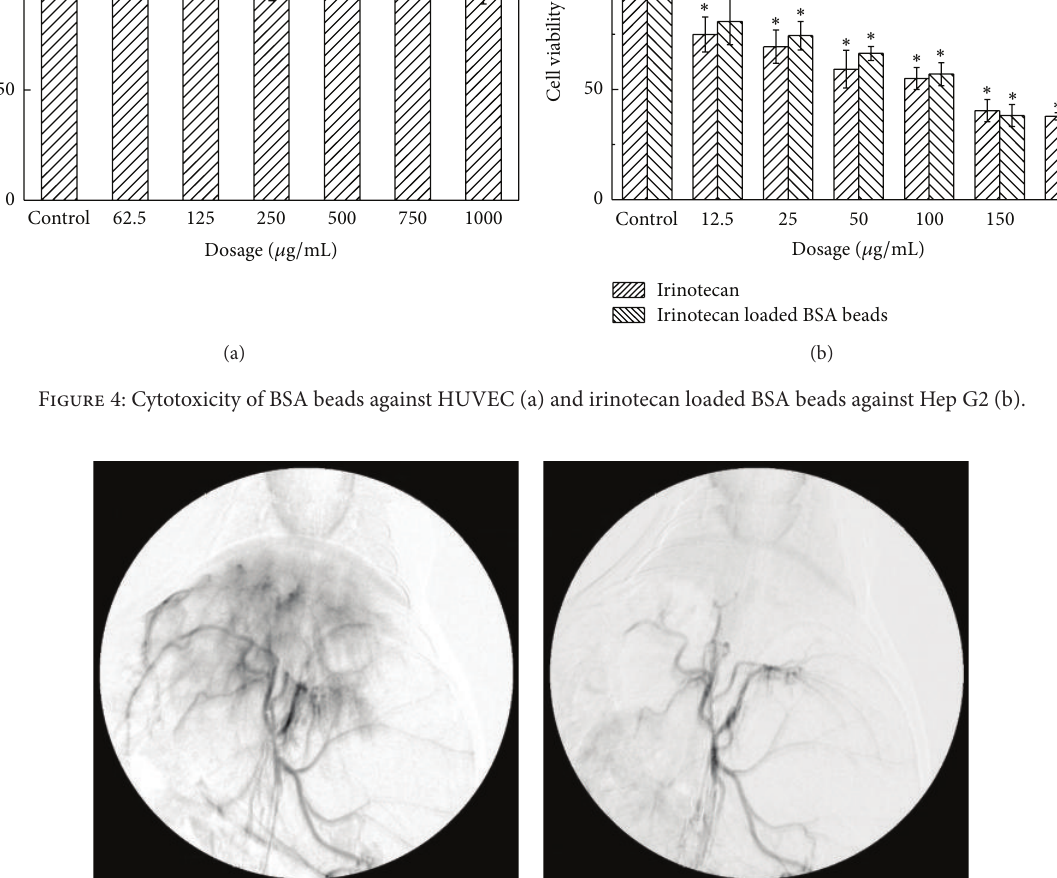
with BSA beads at various concentrations for 24 h. As